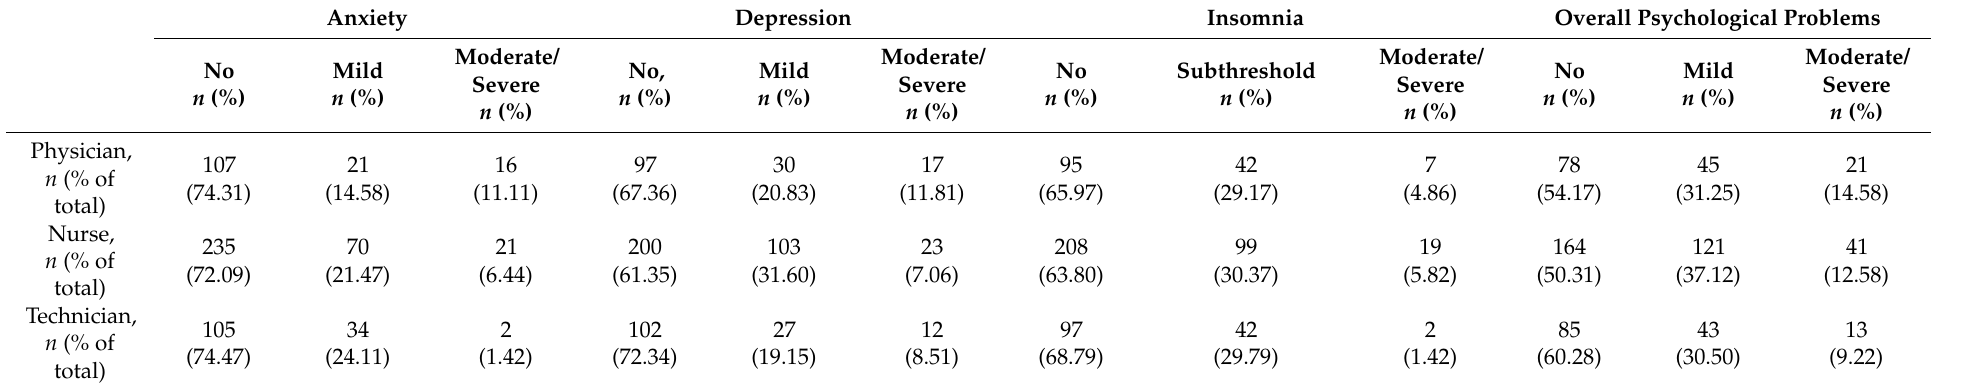
Table 2. Prevalence of psychological problems according to the groups of healthcare